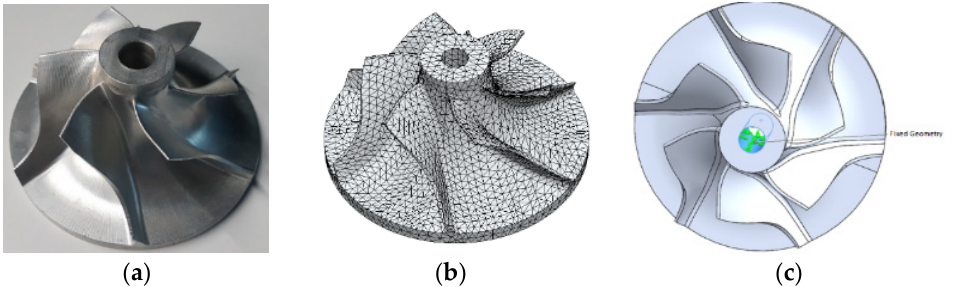
Figure 3. ( a ) Impeller; ( b ) The mathematical mesh finite element model; ( c ) The boundary condition.